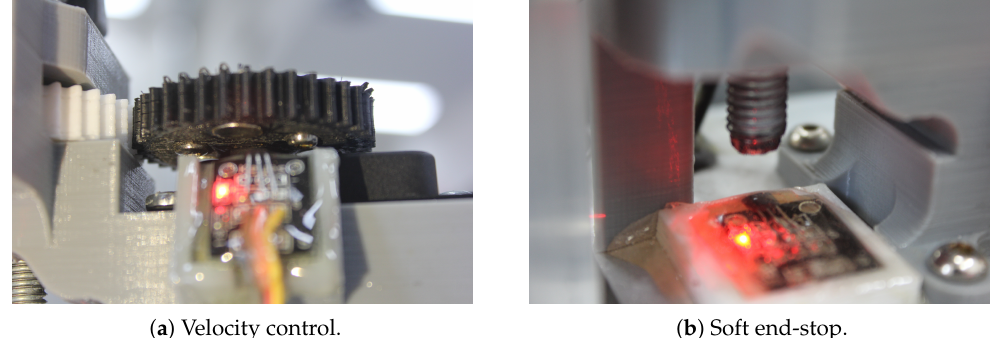
Figure 5. Photos of the Hall-effect sensors.